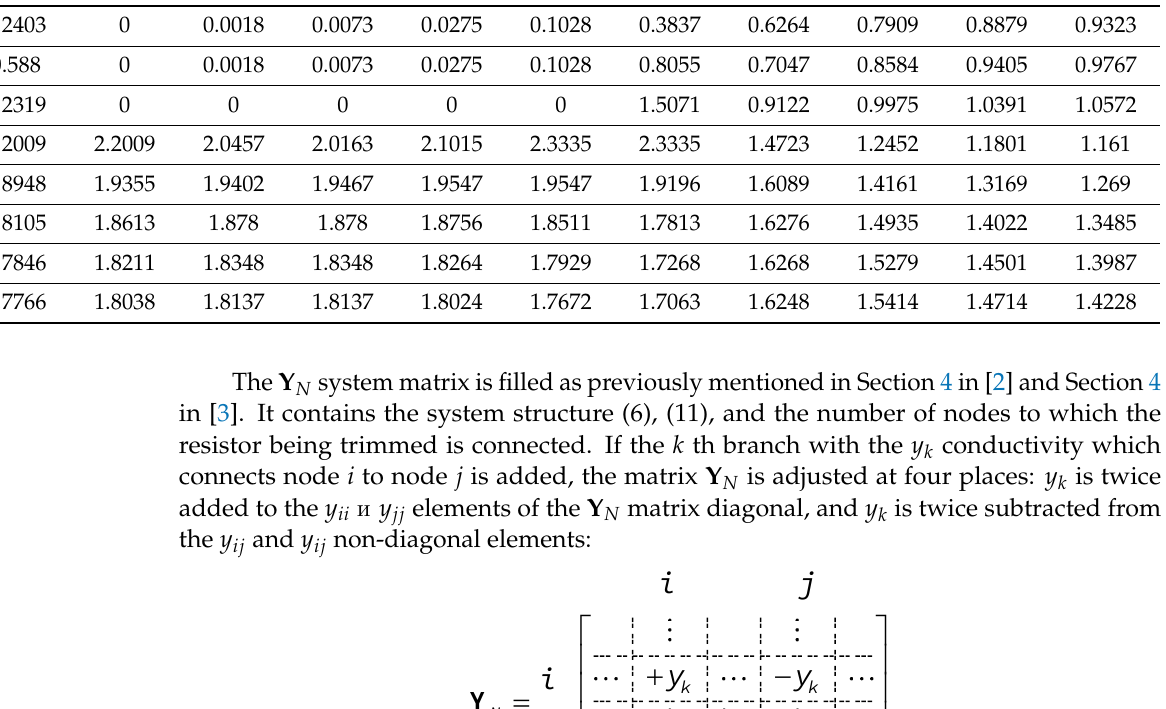
Table 8. Arr3NodeI array contents.